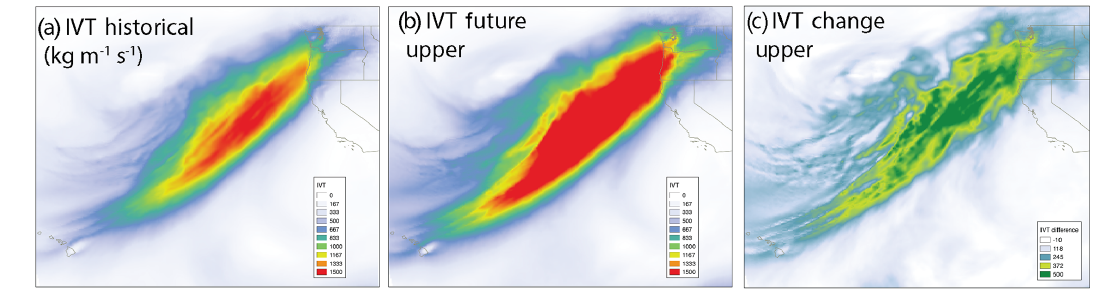
Figure 7. (a) WRF-control simulated IVT (kgm − 1 s − 1 ) for 3 December 2007, (b) WRF-PGW simulated IVT (kgm − 1 s − 1 ) for 3 December 2007 for the upper scenario and (c) absolute change in IVT between the WRF-PGW upper scenario and WRF-control.